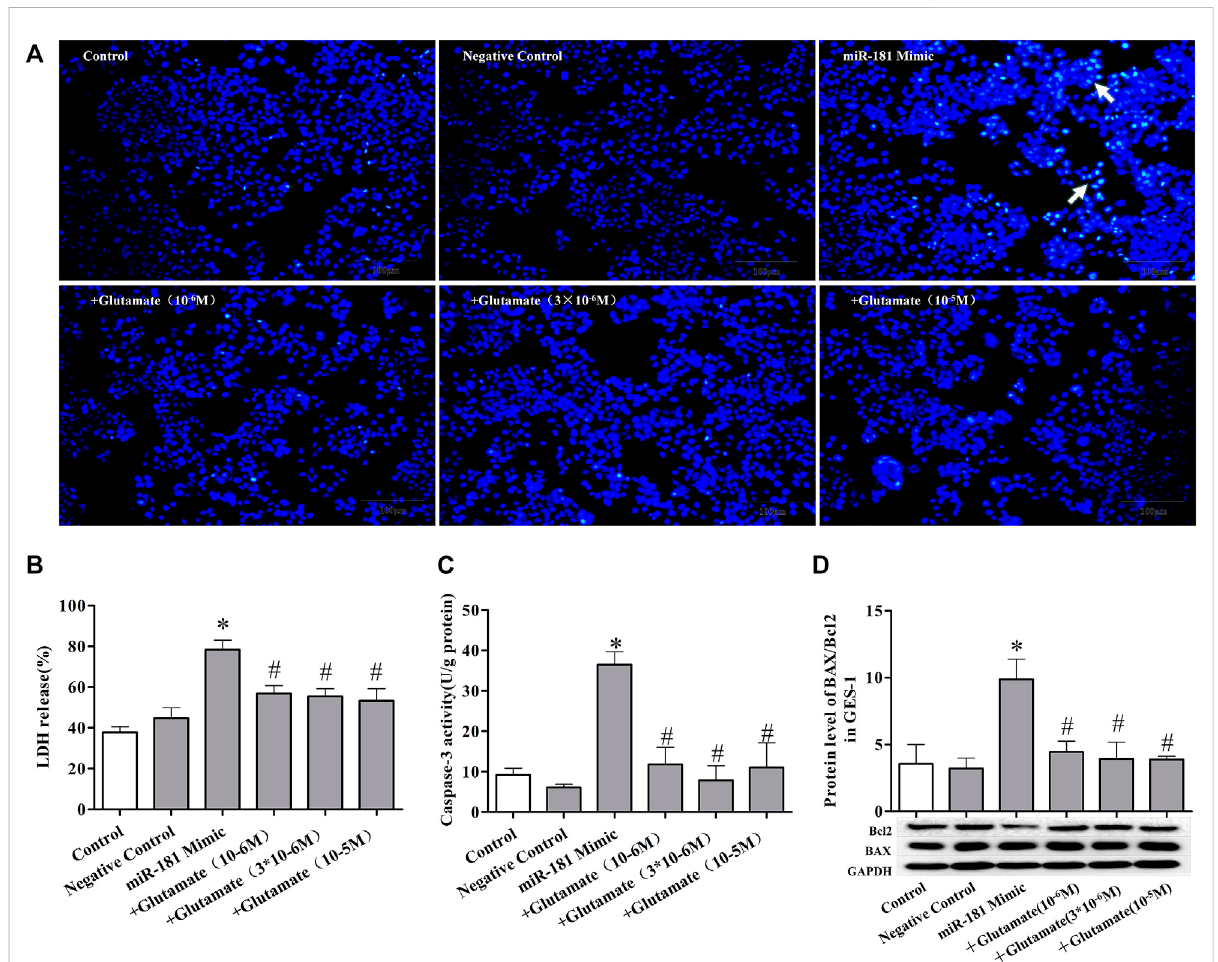
FIGURE 7 Cell damage induced by miRNA mimics can be attenuated by exogenous glutamate supplementation. (A) Protective effect of glutamate on gastricmucosalepithelialcellapoptosisaftertreatmentwithmimicmiR-181(Hoechststaining,×100). (B) LDHrelease. (C) Caspase-3activity. (D) The ratio of BAX/Bcl-2 in gastric mucosal epithelial cells. Data are expressed as mean ± standard error ( n = 3). # p < 0.05 vs. MicroRNAs mimic, * p < 0.05 vs. Negative